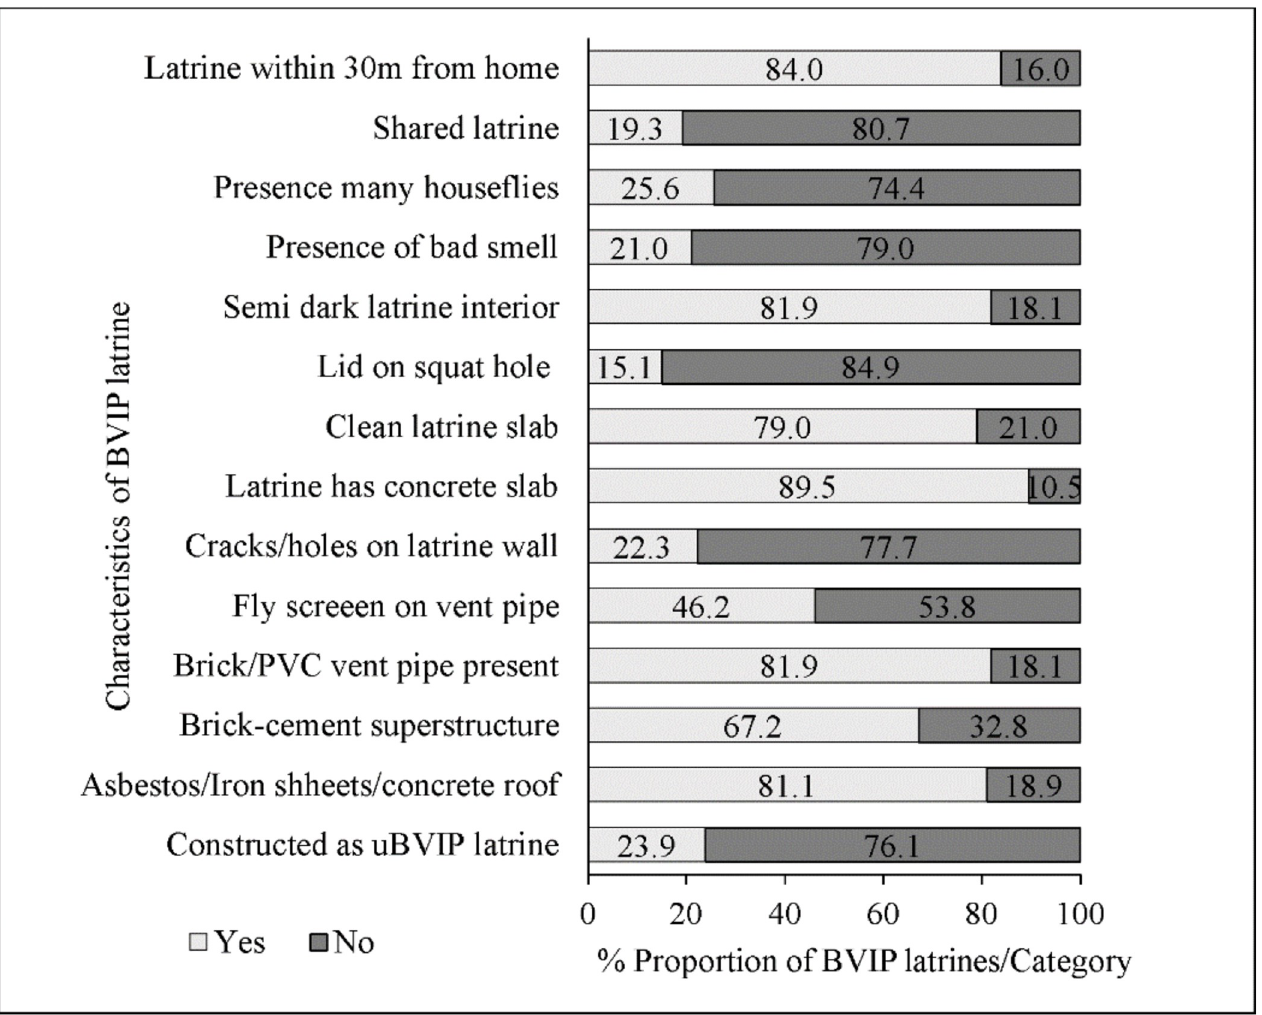
Fig 1. Characteristics of household BVIP latrines in rural villages of Mbire district, northern Zimbabwe, 2021 (n = 238).